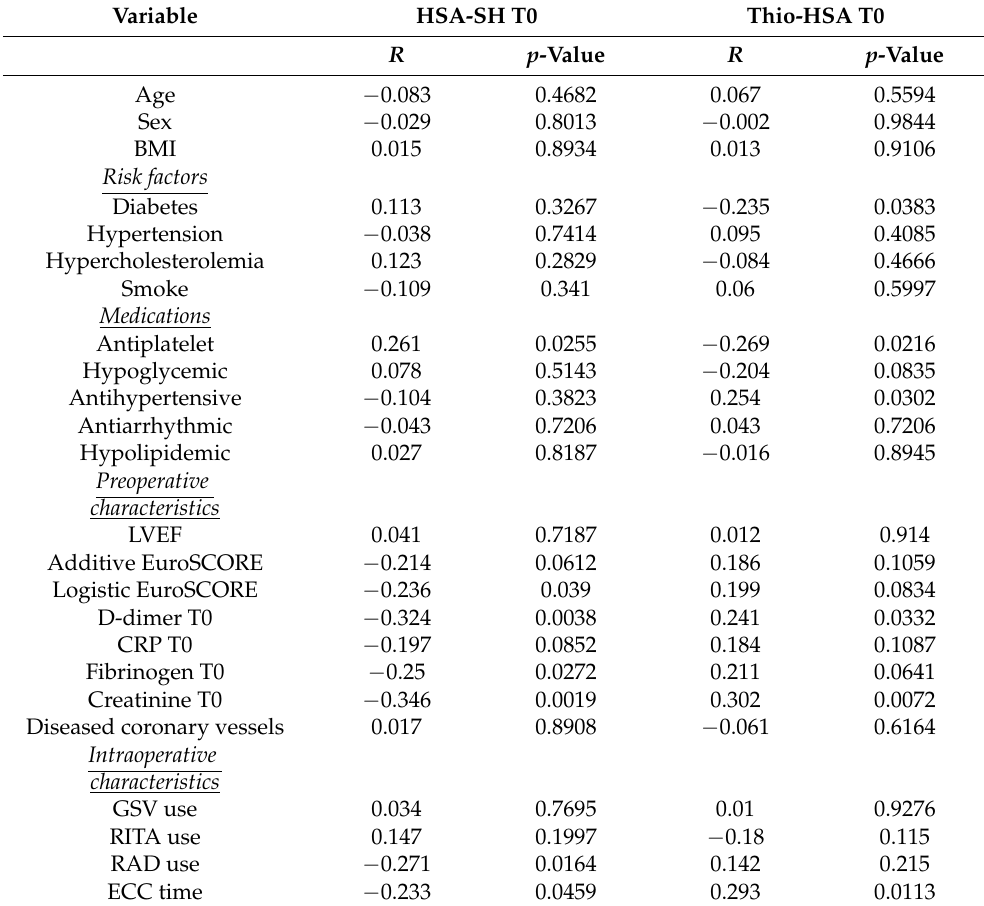
Table 2. Spearman correlations between preoperative albumin isoforms and baseline clinical charac- teristics.